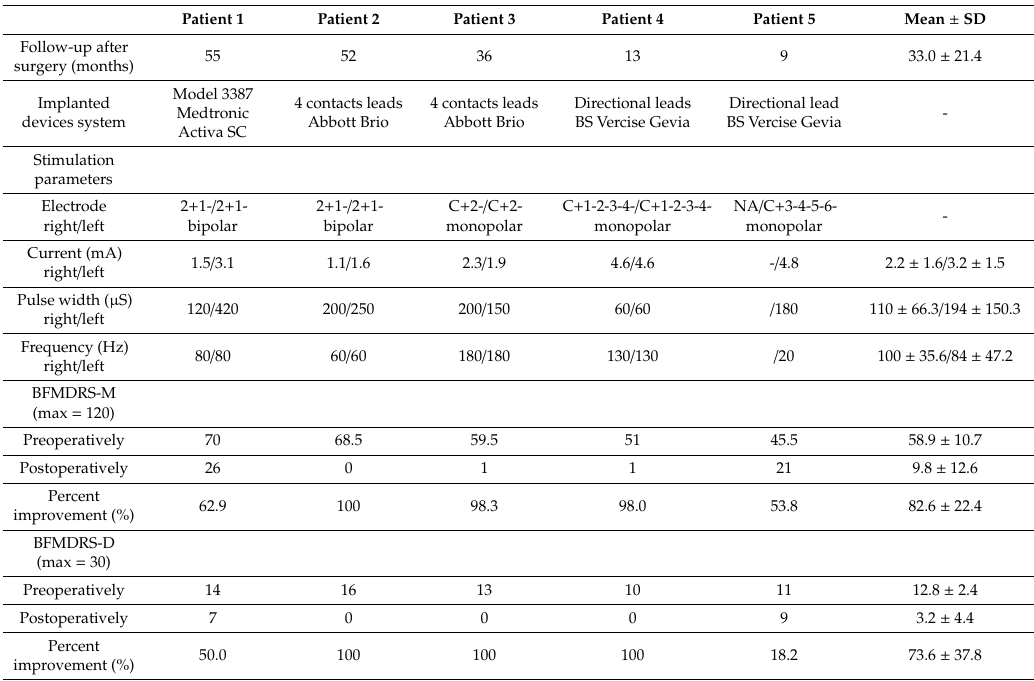
Table 2. Detailed information about pallidal deep brain stimulation in patients with borderline dystonia. Patient 1 Patient 2 Patient 3 Patient 4 Patient 5 Mean ± SD Follow-up after surgery (months) Implanted devices system